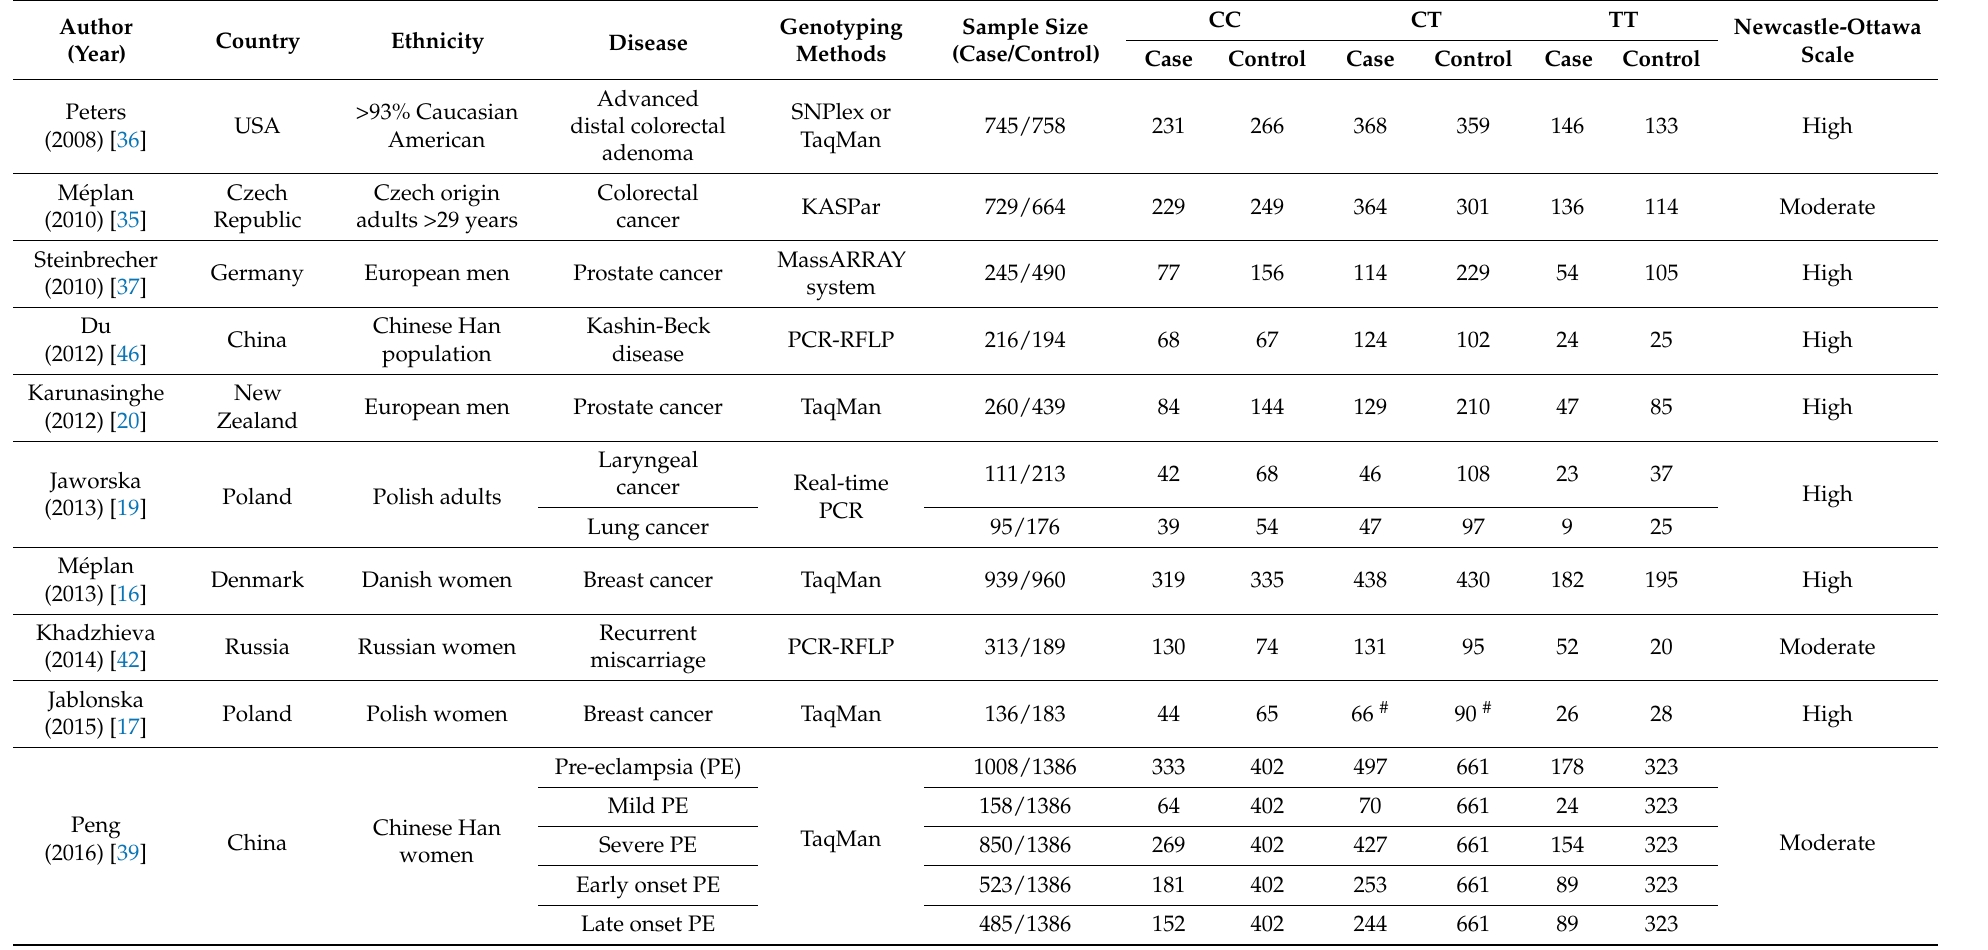
Table 1. Main characteristics of studies included in the systematic review and meta-analysis (n =